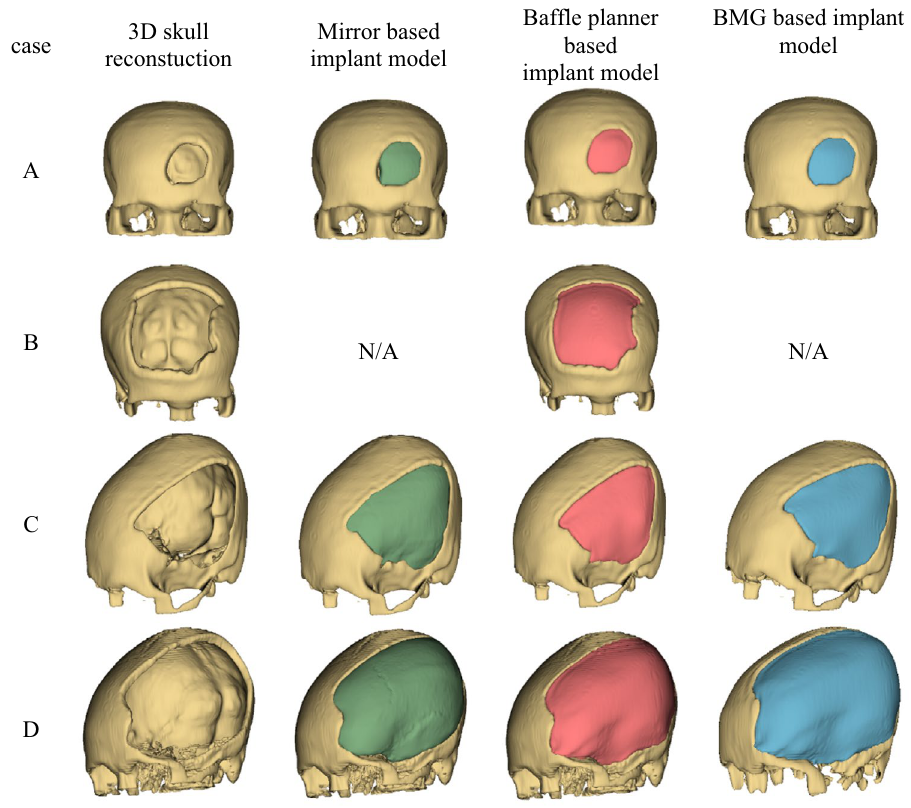
Figure 11. Customized craniofacial implants models for case ( A–D ) were created using the three techniques: (I) mirror, (ii) baffle planner and (iii) baffle-based mirror guideline. Note that the mirror and BMG techniques cannot create implant model for case B. N/A means that the implant model cannot be